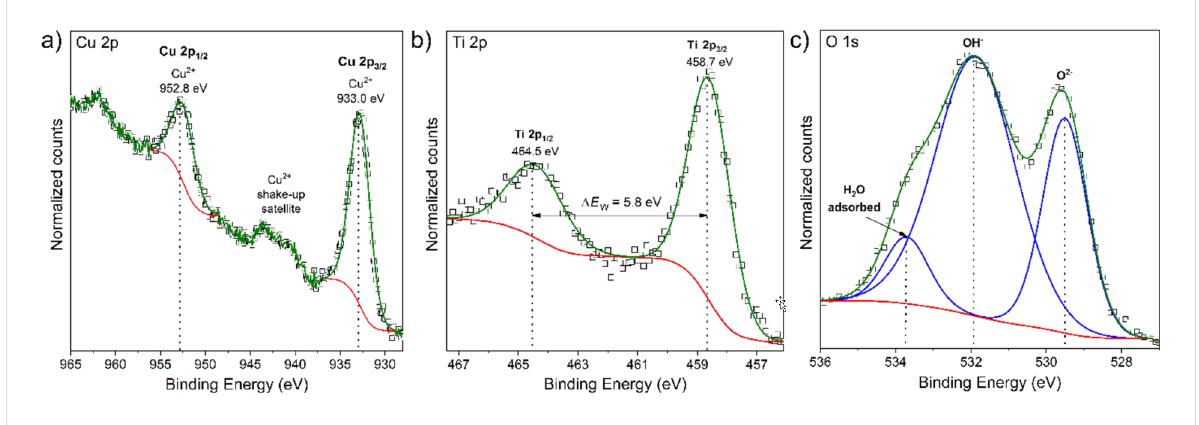
Figure 6: XPS spectra of the surface of (Ti 0.48 Cu 0.52 )Ox thin film: a) Cu 2p, b) Ti 2p, and c) O 1s core levels.